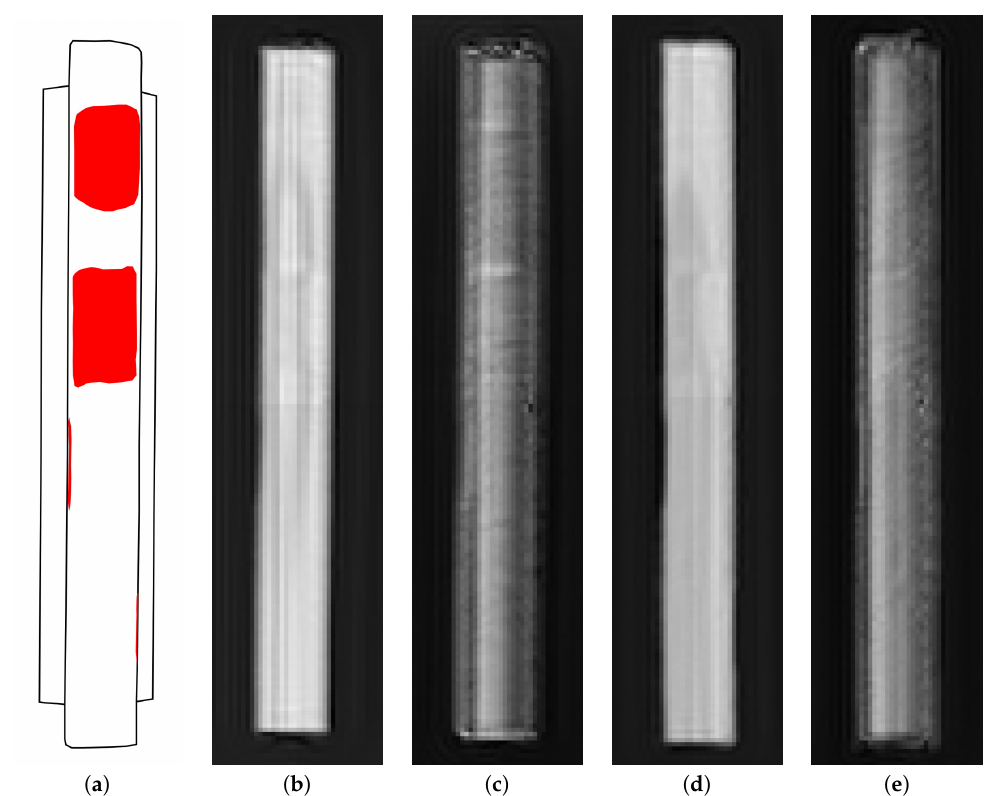
Figure 6. The map of defects and radar images of the rail fragment #2 in various transmit and receive polarizations: ( a ) the map of defects; ( b ) transmit and receive polarizations are along the rail fragment; ( c ) transmit polarization is along, receive polarization is across the rail fragment; ( d ) transmit and receive polarizations are across the rail fragment; ( e ) transmit polarization is across, receive polarization is along the rail fragment.